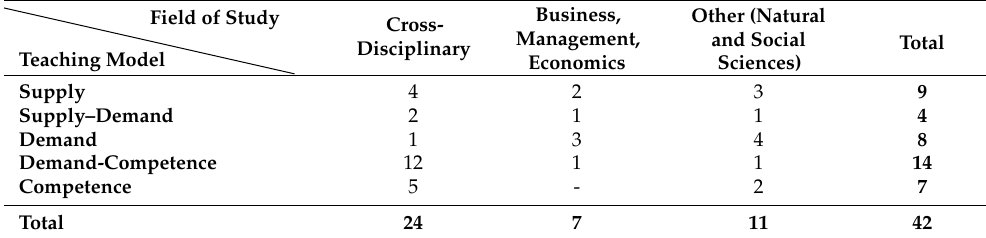
Table 4. Distribution of courses according to teaching models and